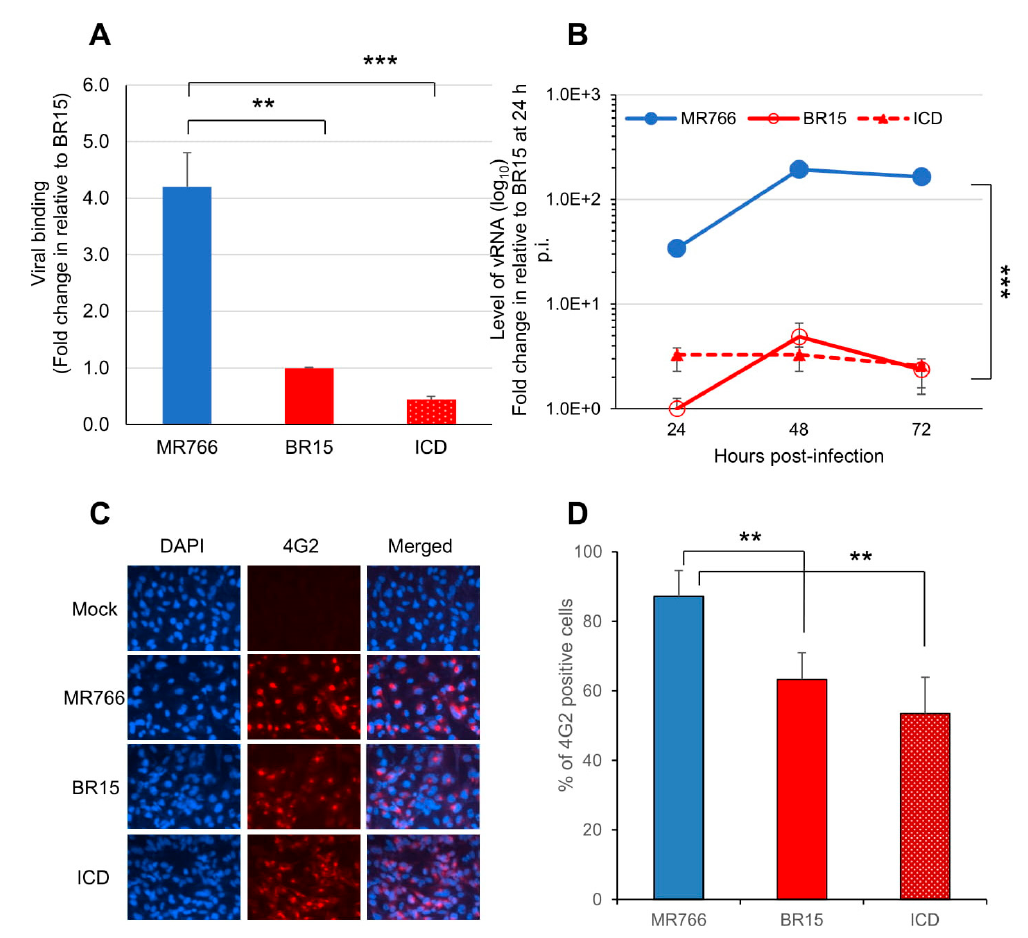
Figure 1. Different infectivity between the epidemic Brazilian Zika virus (BR15 and ICD) molecular clones and the historical African MR766 molecular clone in human brain glial SNB-19 cells. ( A ) Viral binding to SNB-19 cells was measured by presence of cell-associated vRNA one-hour post-infection (p.i.). A housekeeping gene GAPDH was used as an endogenous control for the measurement of viral bindings. ( B ) Zika virus (ZIKV) replication was measured by quantitative RT-PCR with timeframe as indicated. SNB-19 cells were infected by Zika viruses with multiplicity of infection (MOI) 1.0. Results represent average and standard deviation (X ± SD) of four independent experiments. ( C ) Viral infectivity measured by anti-E mAb 4G2 at 48 h p.i. ( D ) Viral infectivity is shown as an average of three different experiments, each carried out in triplicates. Average cell number counted was about 100–200. Results represent average and standard deviation (X ± SD). Levels of statistical significance were calculated by two-tailed and paired t-test for ( A ), and Two-way ANOVA was used for ( B ). **, p < 0.05; ***, p < 0.01.